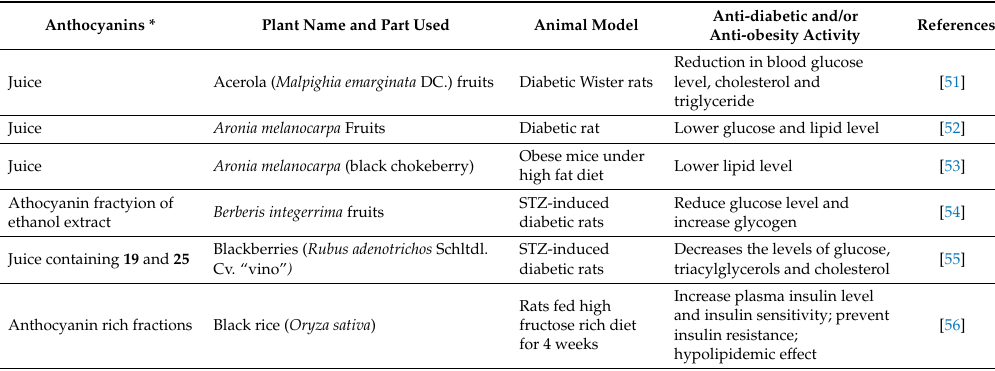
Figure 3. Underlying mechanism of anthocyanins against insulin resistance associated with diabetes and/or obesity. The decrease in insulin resistance and enhancement of insulin sensitivity by anthocyanins in target organs have been shown to be mediated through activation of the AMPK (adenosine monophosphate-activated protein kinase) and downregulated the serine phosphorylation of IRS-1 (insulin receptor substrate 1), enhanced GLUT4 (glucose transporter 4) translocation by increasing the activity of PPAR- γ (peroxisome proliferator activated receptor-gamma), lowering the hs-CRP (high sensitivity C reactive protein) concentration, and reduction of retinol binding 4 (RBP4) expression. The reduction of weight gain by anthocyanins is also reported through mechanisms including reduction in the SREBP-1(sterol regulatory element-binding protein 1) mRNA level and inhibition of fatty acid (FA) and triglycerol (TG) synthesis enzymes as well as downregulation of lipogenic factors and upregulation of lipolytic enzymes. Table 3. In vivo effects of anthocyanins against insulin resistance or